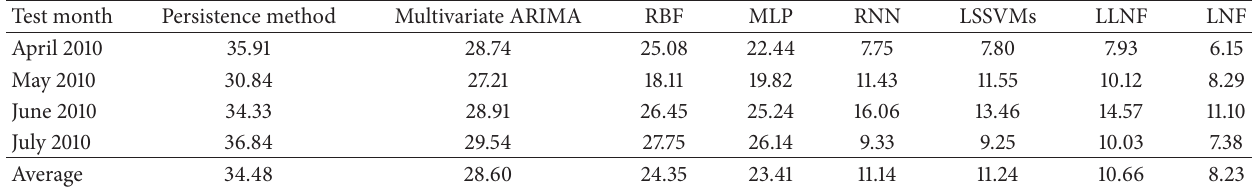
Table 4: Performance comparison based on MAPE (%).